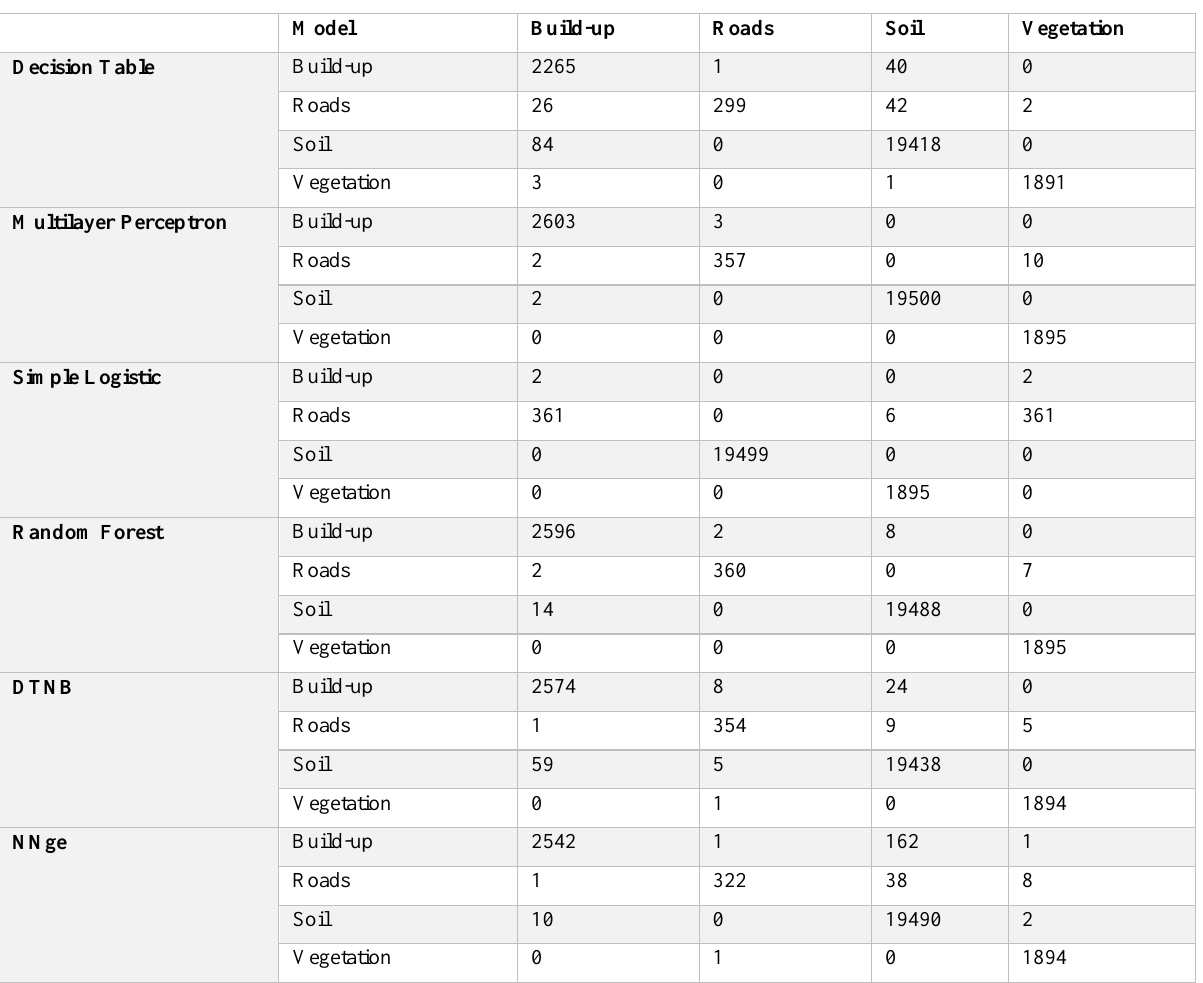
Table 5: Confusion matrix of advanced data mining